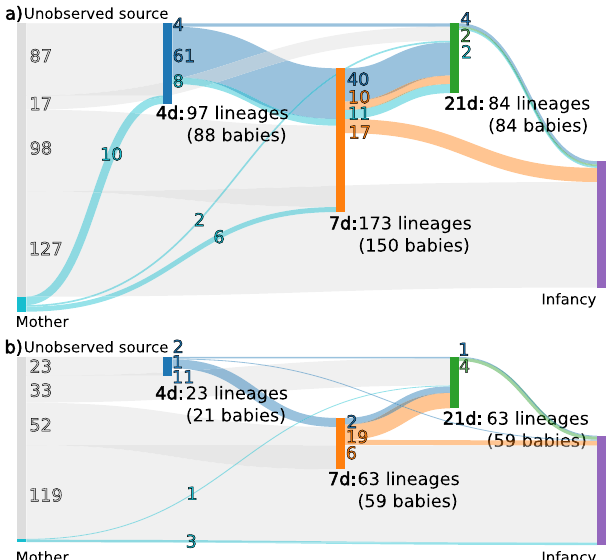
Fig.4|Summary fi gureof E.coli gutcolonisation. Theplotdisplaysthenumbers of E.coli lineages found ateach of the fi ve major sampling points(4, 7, and 21days after birth, in the infancy period, and from the mothers in the maternity unit). The fl ows indicate the (possible) numbers of lineages that were transmitted between the sampling points, with the colours corresponding to the fi rst time point the transmitted lineages were detected in. Flows that skip a sampling point (such as from4daysto21days)indicatethatalineagereturnedtodetectablelevelsafterthe skippedsamplingpoint. a Displaysthevaginaldeliverycohort,and b thecaesarean section